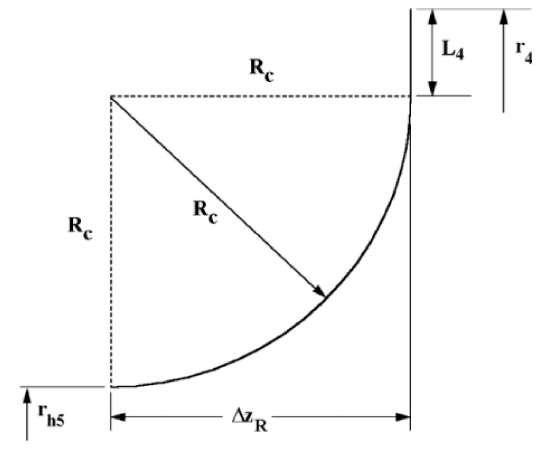
Figure 4. Rotor hub